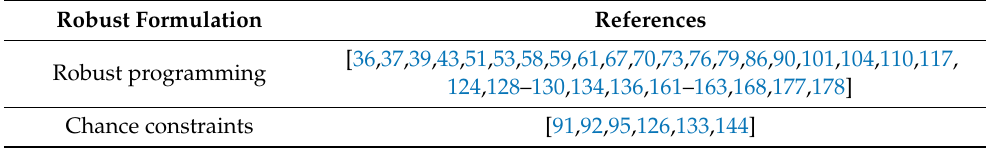
Table 4. Classification of robust and chance constraints programming mathematical formulations. Robust